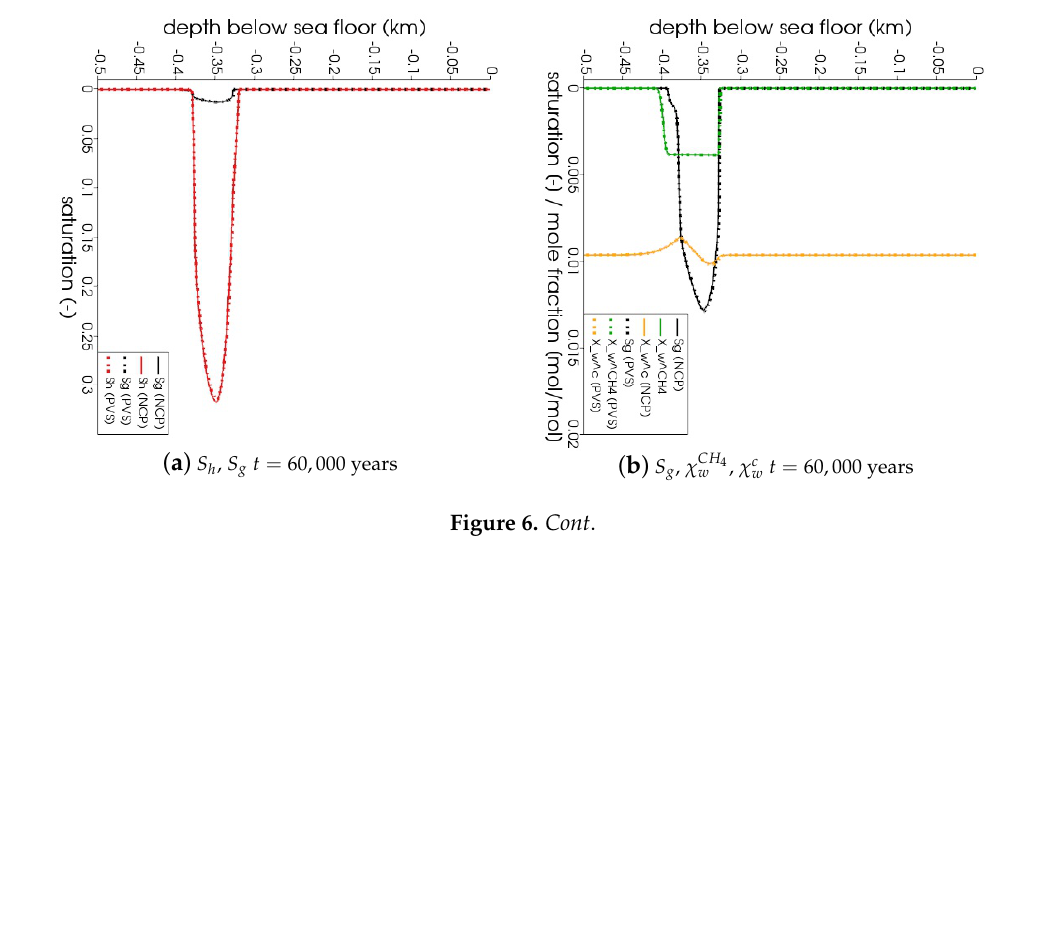
Figure 5. Numerical results for Example 1 (Section 4.1). The figure shows snapshots of S h , S g , χ CH 4 w , and χ c w at t = 22,500 years, that is, the time when the gas phase first appears; t = 135,000 years, that is, the time up to which the PVS scheme solved in 240 CPU-hours; and t = t end = 300,000 years. For t = 22,500 years and t = 135,000 years, the solutions of both NCP and PVS schemes is plotted for comparison.